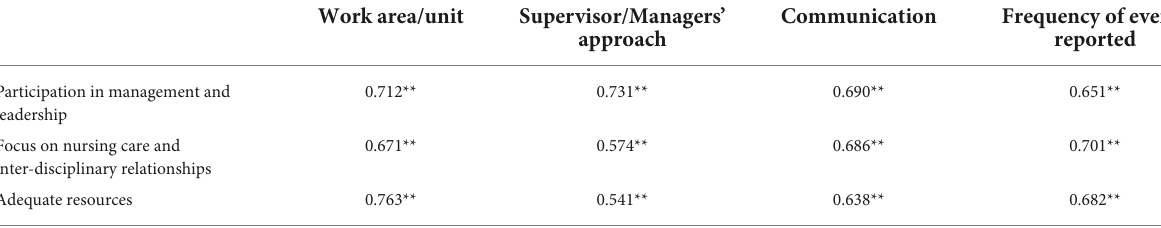
TABLE 4 Correlations between practice environment subscales, and patients’ safety subscales using Pearson’s product-moment. Work